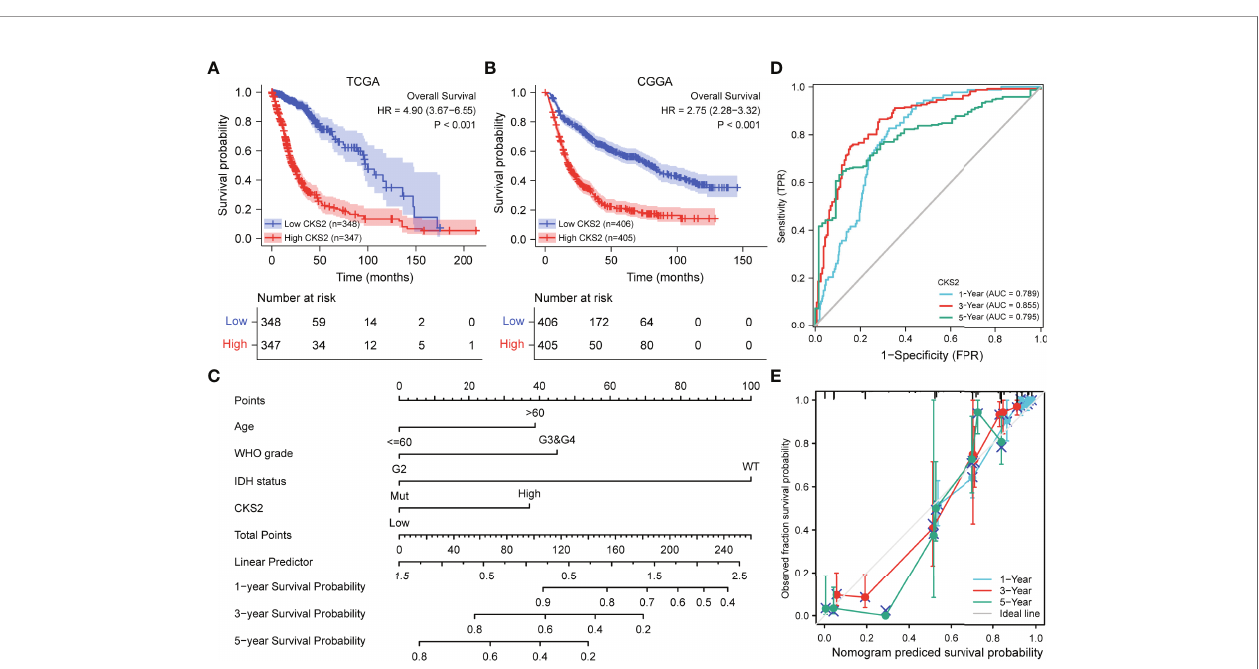
FIGURE 3 | Relationship between the expression of CKS2 in glioma and prognosis. (A) Overall survival (OS) curve based on TCGA data (n = 695). (B) OS survival curve based on CGGA data (n = 811). (C) The nomogram of CKS2 and other glioma prognostic factors from TCGA. (D) Time dependent on ROC curve of the line graph. (E) Prediction of the calibration curve of the line